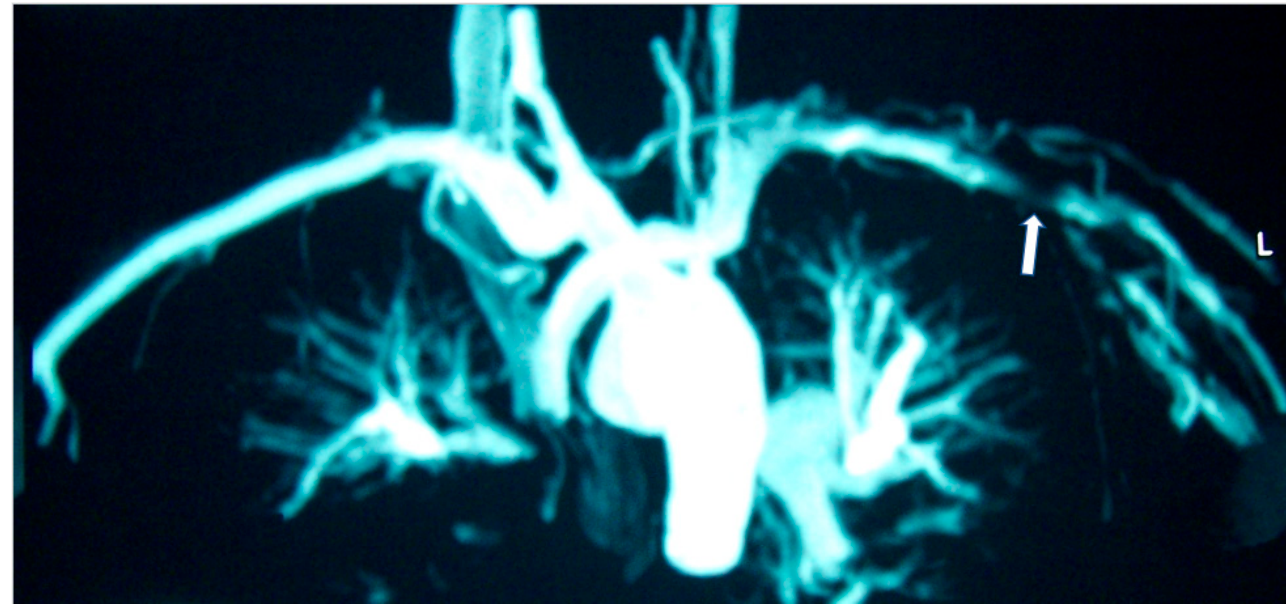
Figure 2. MRA of a patient with Takayasu disease showing left (L) subclavian artery stenosis (arrow).